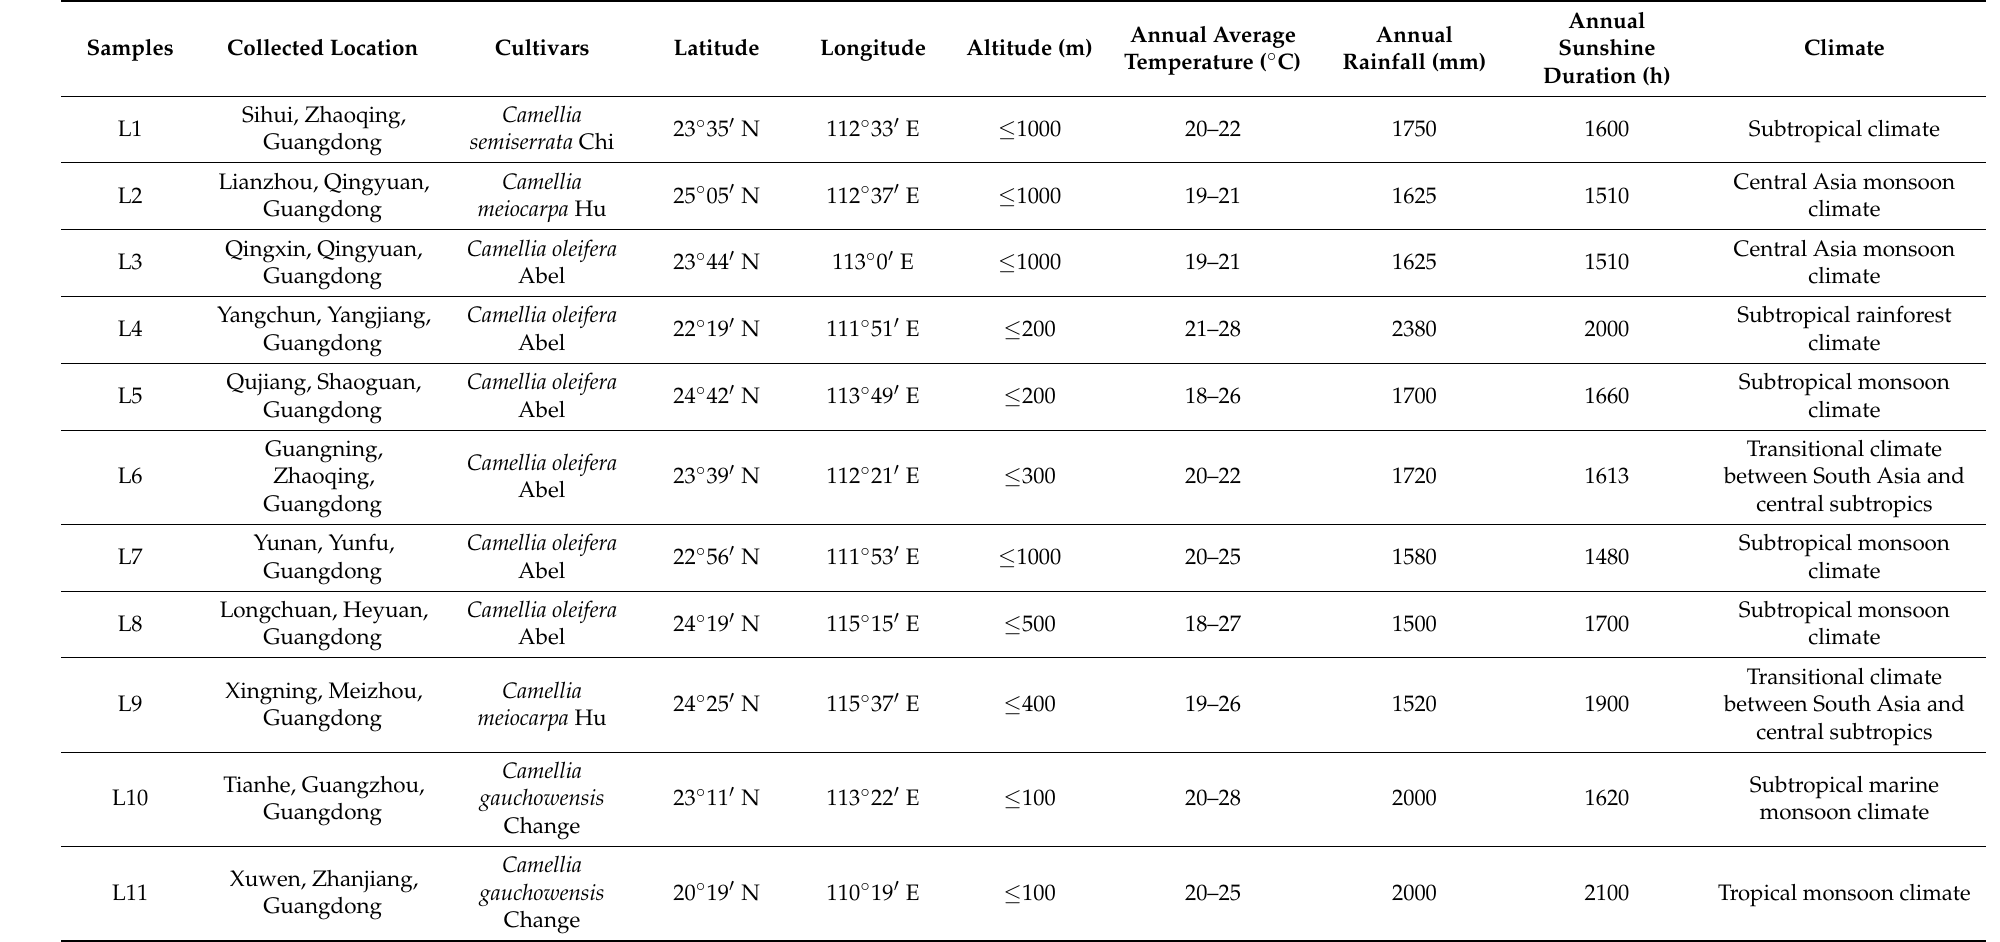
Table 3. Geographical ecological factors of different sampling